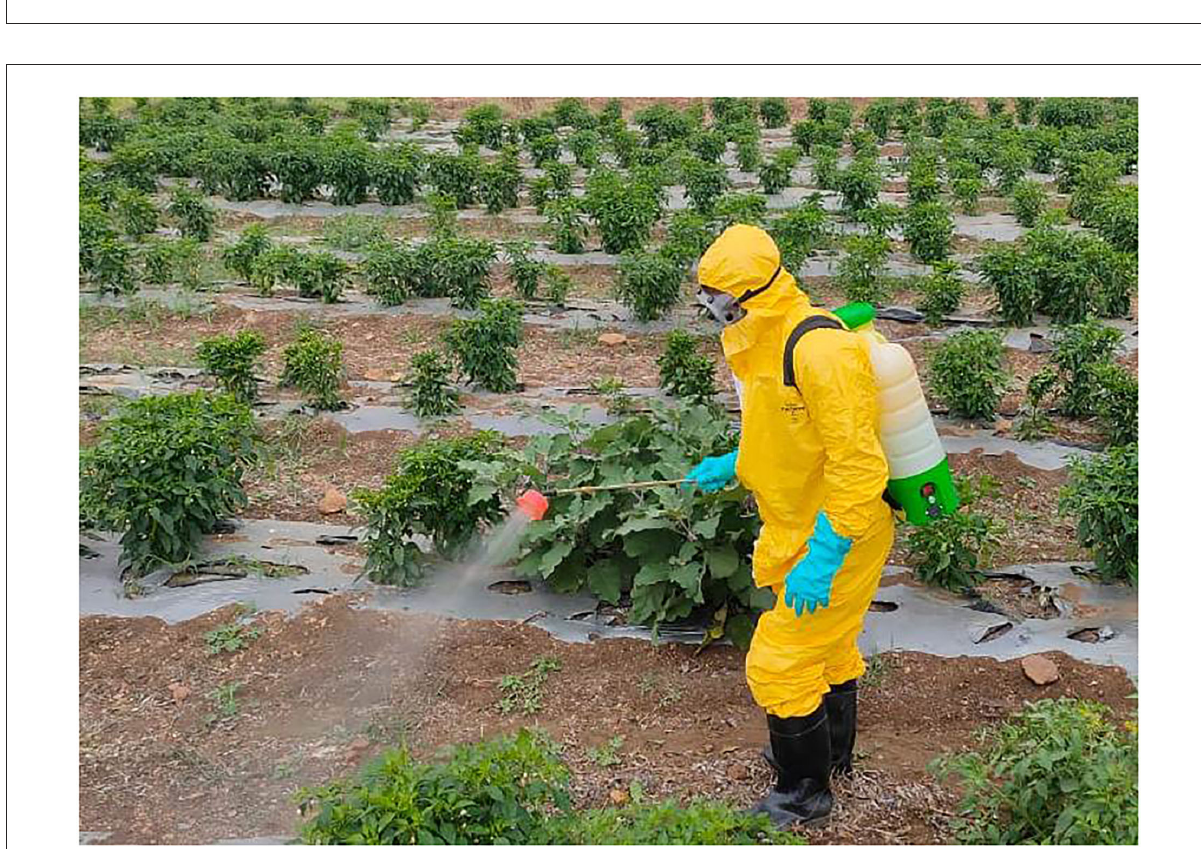
FIGURE3 Operator involved in spraying activity after wearing provided